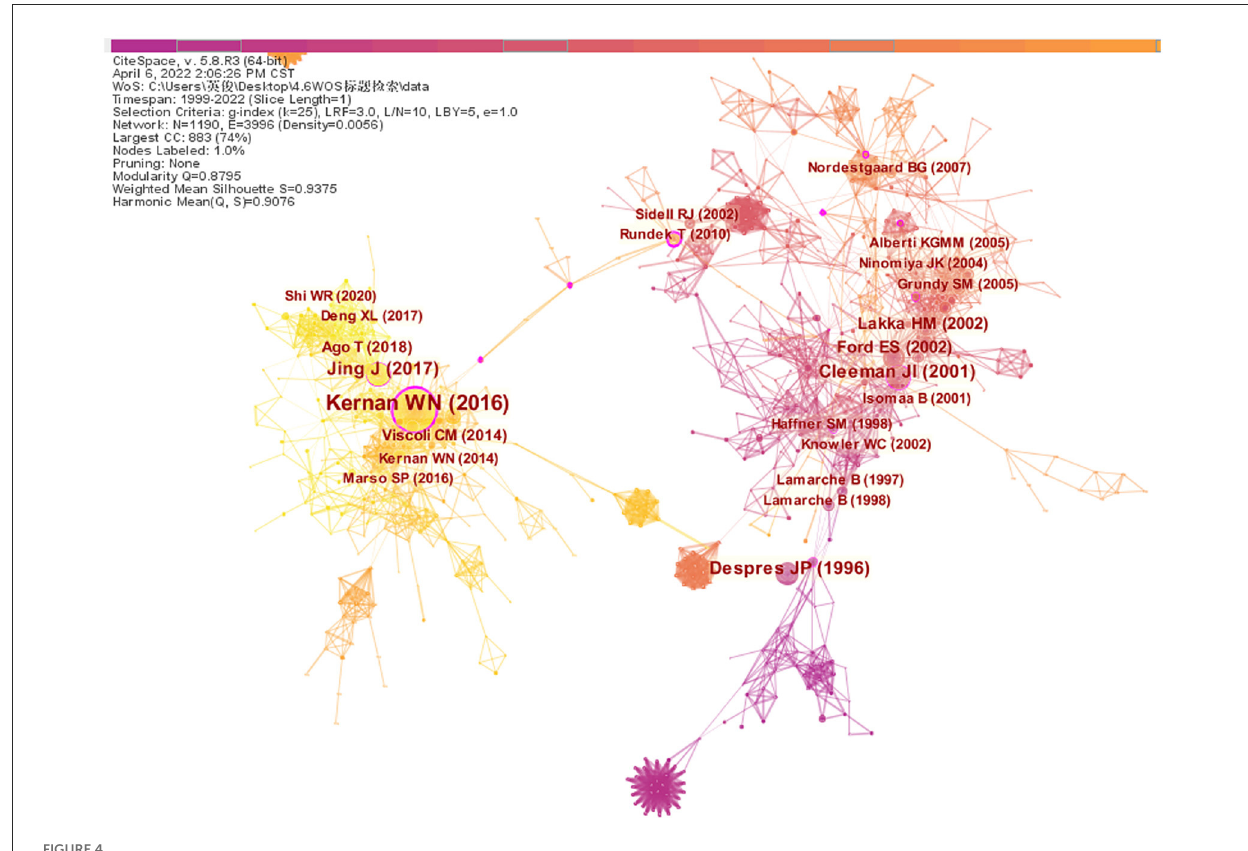
FIGURE4 The network of co-cited references.